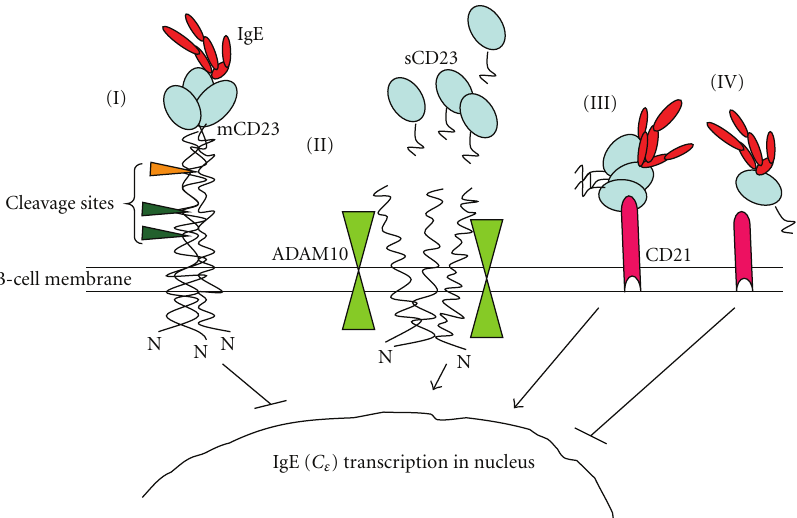
Figure 2: Interaction between CD23 and its ligands, IgE and CD21. Binding of IgE stabilises membrane-bound CD23 and inhibits IgE synthesis (I) from activated B cells while in the absence of IgE binding the CD23 is cleaved by ADAM10 (a disintegrin and metalloprotease protein 10) and this destabilisation enhances IgE synthesis (II). However, soluble CD23 (sCD23) fragments resulting from the cleavage have the ability to bind IgE with di ff erent a ffi nities depending on their oligomerization state: trimers (III) bind IgE with high a ffi nity while monomers (IV) bind with low a ffi nity. Trimers enhance IgE synthesis by their ability to also bind CD21 receptor (III) while monomers fail to bind CD21 and inhibit IgE synthesis (IV) (adapted from